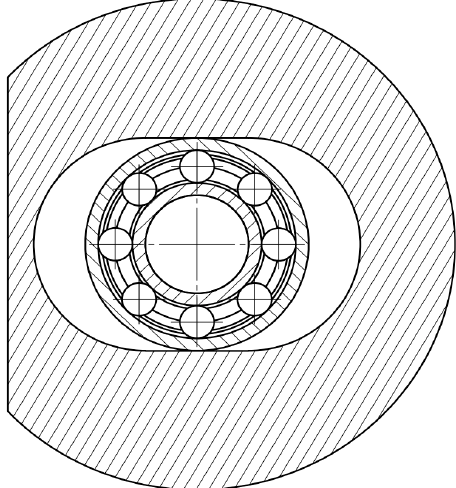
Figure 7. Section “A-A” indicated in Figure 6: the ball bearing outer ring seated in an oblong limits the movement of the mechanism to just one plane.